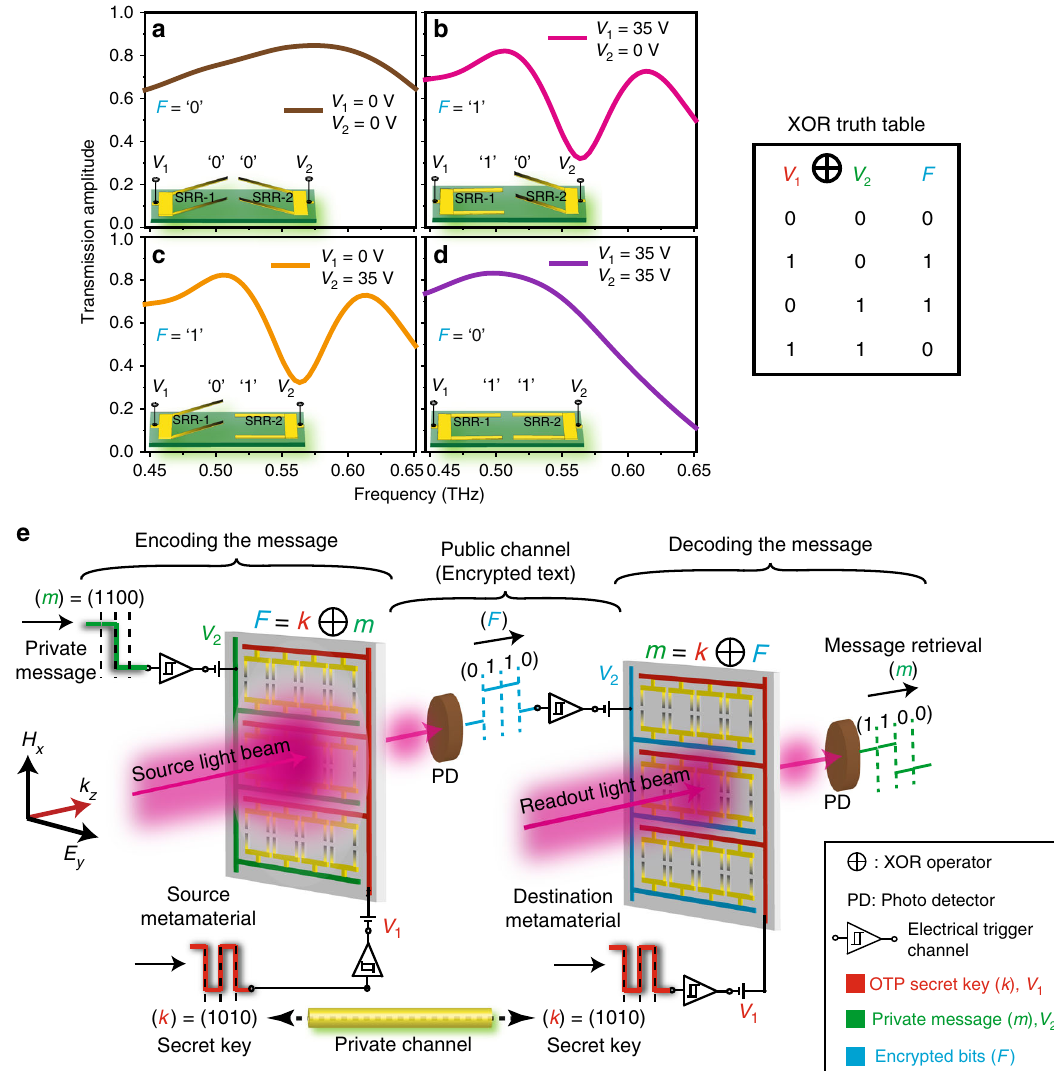
Fig. 4 Exclusive-OR (XOR) logic operation with MEMS Fano-metasurface and its signi fi cance in cryptographic wireless communication networks. a – d Measured far- fi eld THz transmission spectra of the MEMS Fano-metasurface showing the XOR logic feature in the form of presence/absence of Fano resonance (at 0.56 THz) for various structural/voltage states of the SRRs. a , d show the symmetric con fi guration of the structures ( 00 and 11 ) that signi fi es the absence of Fano resonance excitation ( F = 0 ), whereas b , c represent the asymmetric con fi guration of the structures ( 10 and 01 ) that results in the excitation of Fano resonance feature ( F = 1 ) in the sample. e Pictorial representation of realizing the OTP secured wireless communication channel by performing the XOR logic operation to encode the private message ( m ) with the secret key ( k ) and is sent through the public channel as optical signals. The message is retrieved securely (decrypted) at the destination end by performing the inverse XOR operation on the measured optical states ( F ) with the secret key ( k ). The structural/voltage states of SRR-1 and SRR-2 are expressed as OTP secret key ( k ) and the private message ( m ), respectively, whereas the secured data is transmitted through public channel in the form of optical bits ( F ) results due to the asymmetry in the structural con fi guration of the Fig. 7, intensity contrast between the output states F = 0 and metasurface, for input voltages ( V 1 = 0, V 2 = 35 V and V 1 = 35 V, F = 1 is measured to be equal to Δ T = 0.61 (normalized to the input intensity of 1) at a frequency of 0.56 THz. The proposed V 2 = 0 V) there exist two asymmetric structural con fi gurations ‘ up – down ’ ( 01 ) and ‘ down – up ’ ( 10 ) that results in the true state XOR logic functionality based on the Fano resonance exhibits for the Fano resonance condition (i.e. F = 1 ), as shown in Fig. 4b, substantial improvement in the intensity contrast ratio compared c, respectively. On the other hand, for symmetric structural to earlier demonstrations at THz frequencies 29,40 . Furthermore, another logic functionality that represents the XNOR truth table con fi gurations of the device ( V 1 = V 2 = 0 V and V 1 = V 2 = 35 V), ‘ up – up ’ ( 00 ) and ‘ down – down ’ ( 11 ) results in the absence of Fano is derived from the MIO characteristics observed in the Q -factors resonance ( F = 0 ) state, as shown in Fig. 4a, d. Resulting truth of the Fano resonance, as shown in Fig. 3c. The XNOR logic table is presented in the inset of Fig. 4, which resembles the digital operation signi fi es the true output if both the inputs are either XOR logic operation, where the Fano output is true ( F = 1 ) if the true or false, which is complementary to the XOR logic operation. input voltage states differ, otherwise Fano output results in a false In our measurements, by de fi ning the threshold values to the state ( F = 0 ) (i.e. when both the inputs are either true ( 11 ) or false input voltages ( V 1 , V 2 ) and the output states in the form of Q - factors (inverse of loss-factors), we construct the XNOR ( 00 ), then output state F = 0 ). As discussed in Supplementary NATURE COMMUNICATIONS| (2018) 9:4056 |DOI: